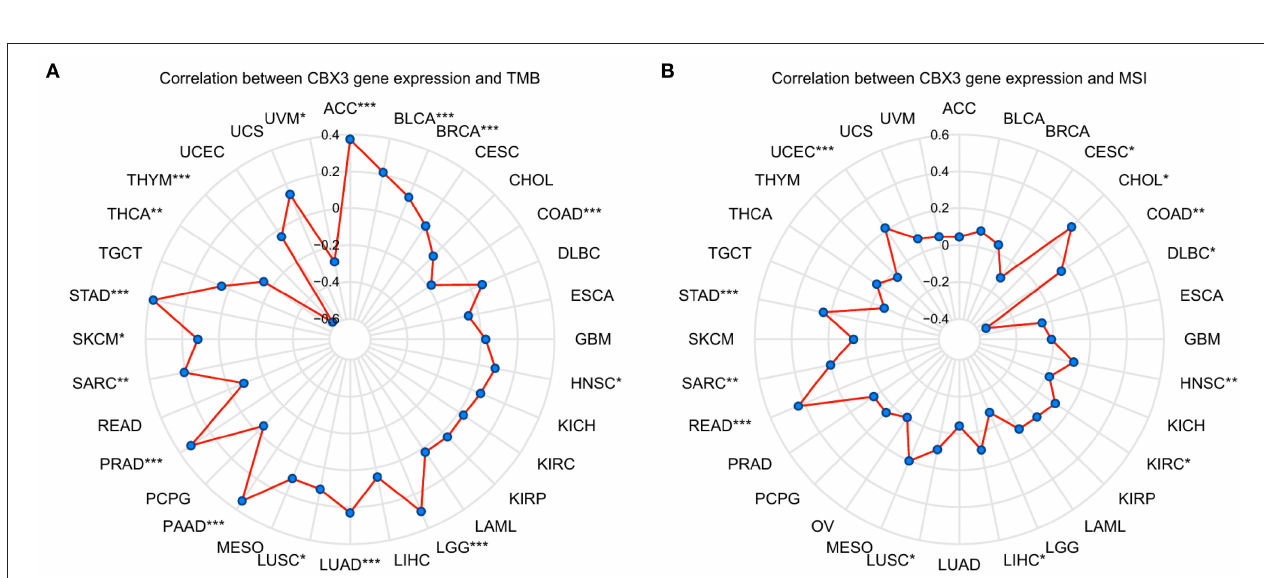
FIGURE 7 | The link between the expression of CBX3 and TMB and MSI. (A) Radar diagram demonstrating the correlation between CBX3 and TMB). (B) Radar diagram demonstrating the correlation between CBX3 and MSI. * P < 0.05, ** P < 0.01, and *** P < 0.001.